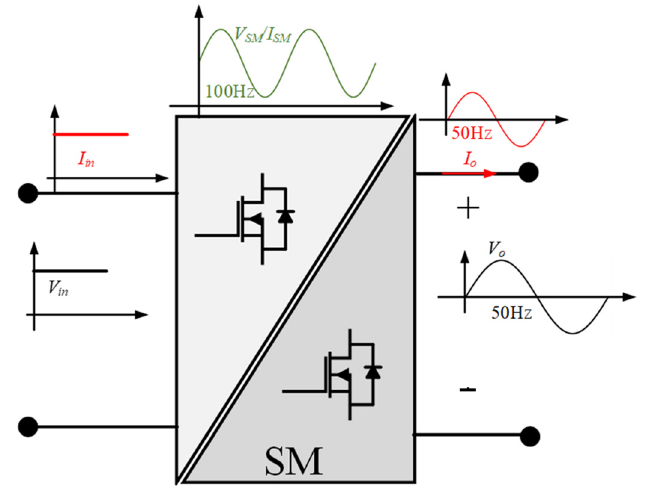
Figure 5. MCI inversion.